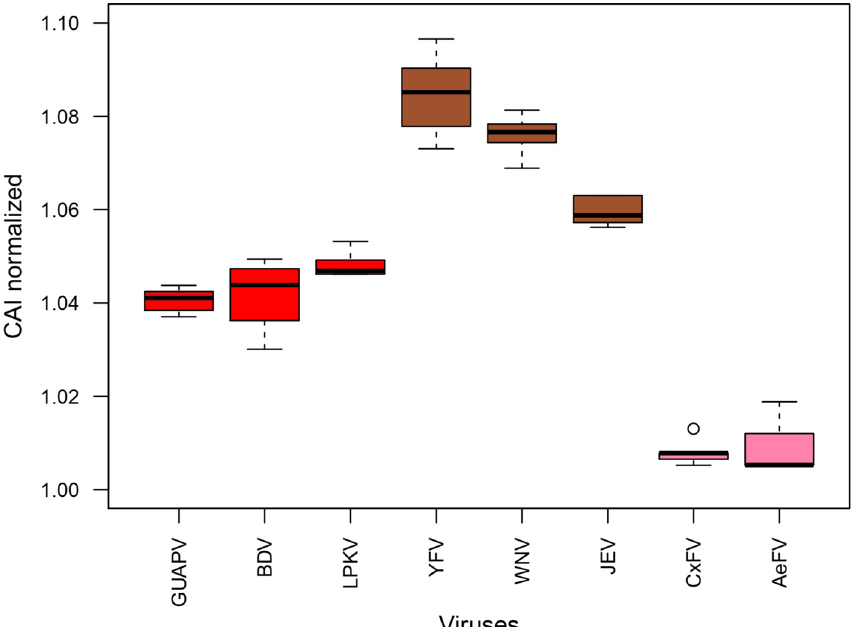
Figure 5. CAI analysis of flavivirus showing signs of codon usage adaptation towards the human host genome. Boxplot for normalized CAI values obtained with polyprotein of dISFV (red box), MBFV (brown box) and cISFV (pink box) was generated using random six strains of each virus. CAI value > 1 was considered as evidence of codon adaptation to human house-keeping